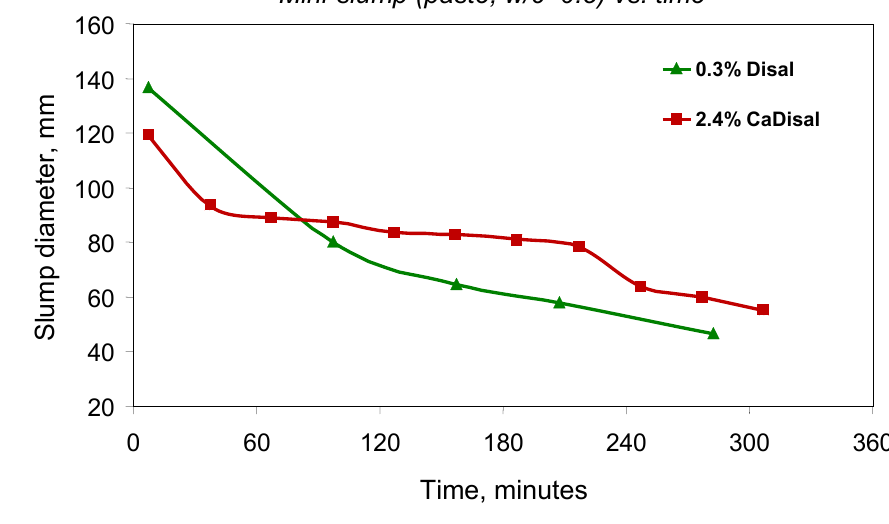
Figure 7. Slump loss with time for selected cement